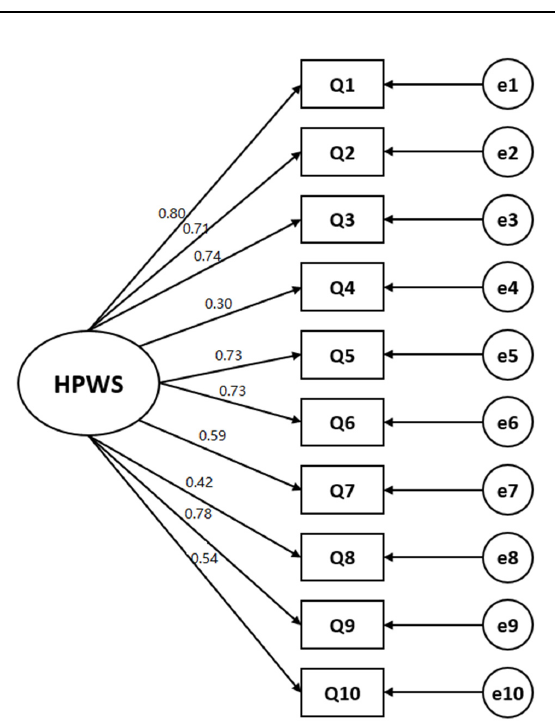
Figure 2. Measurement model of the Korean version of the HPWS Scale (HPWS-K).